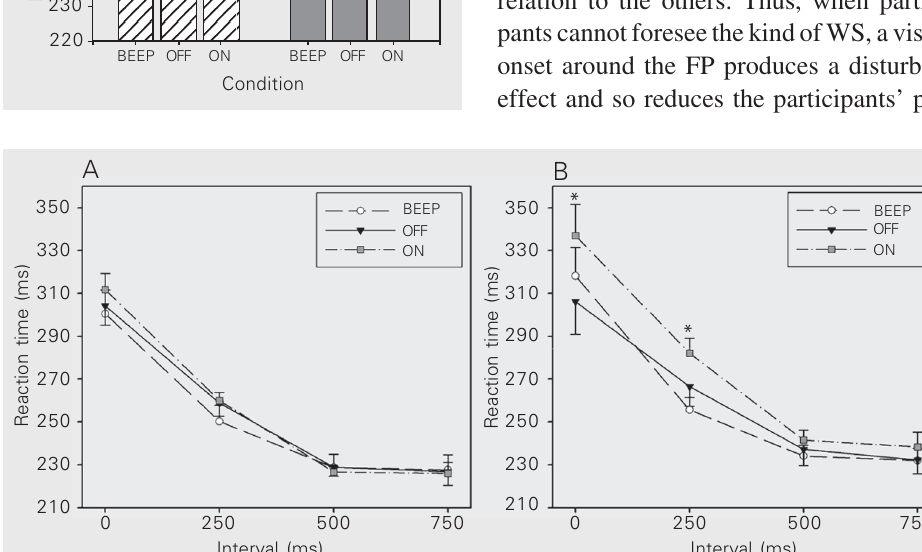
Figure 1. Mean latency of manual reaction times (ms) as a function of condition (BEEP, OFF and ON) and context (blocked and non-blocked). The error bars indicate ± SEM. Planned comparisons showed that in the non-blocked context reaction times for the ON condi- tion were longer than those ob- tained for the OFF condition (*P < 0.05).